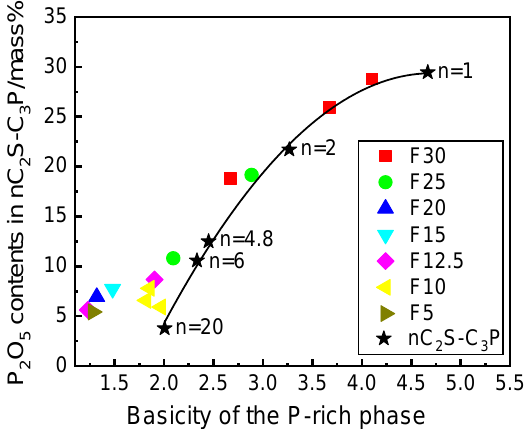
Figure 10. Change of P 2 O 5 contents in nC 2 S–C 3 P (n = 1, 2, 4.8, 6, 20) and in P-rich phase with the basicity of the P-rich phase.